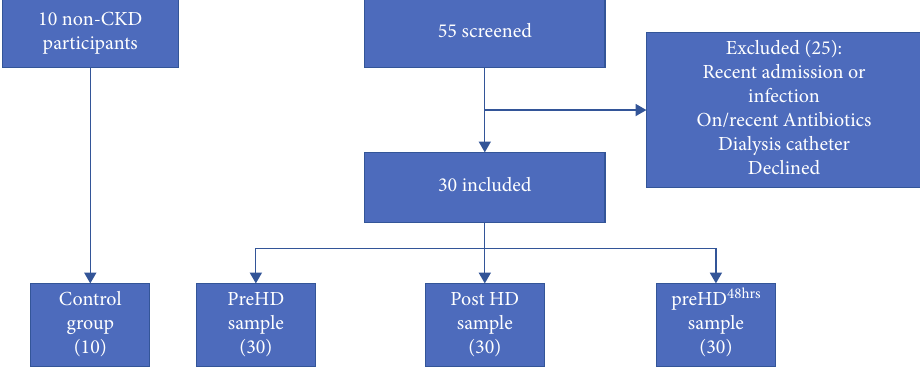
Figure 1: Flow chart of study population. Table 1: Characteristics of HD